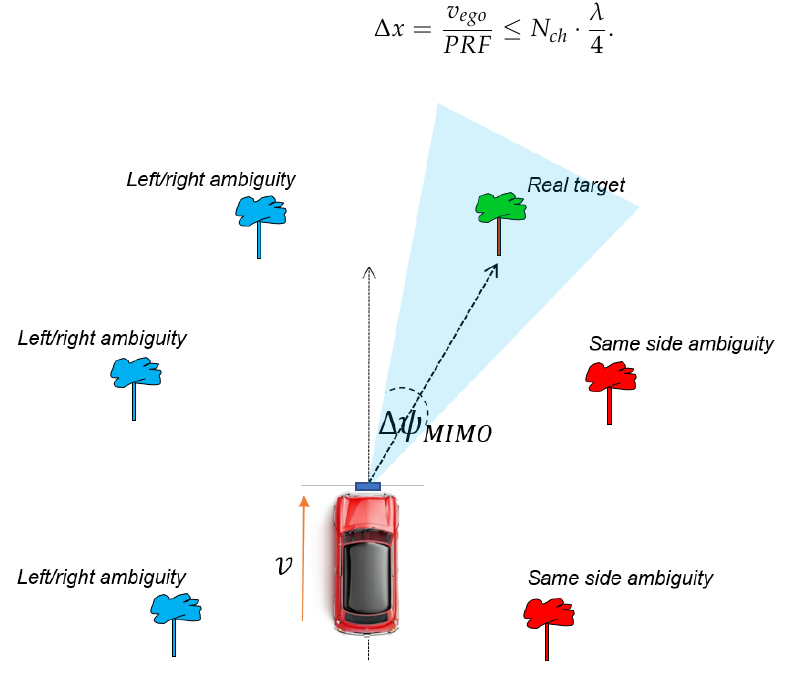
Figure 5. Ambiguities in automotive